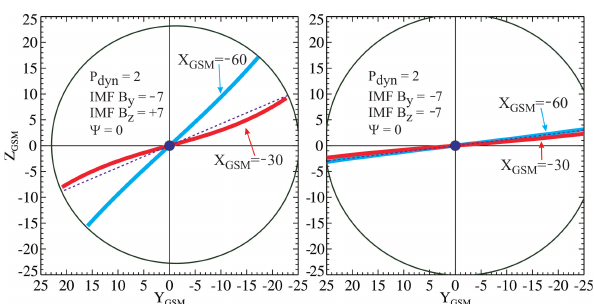
Figure 8. Illustrating the effect of the IMF B z on the shape of the B r = 0 surface in the terminator plane. In both cases P dyn = 2nPa.